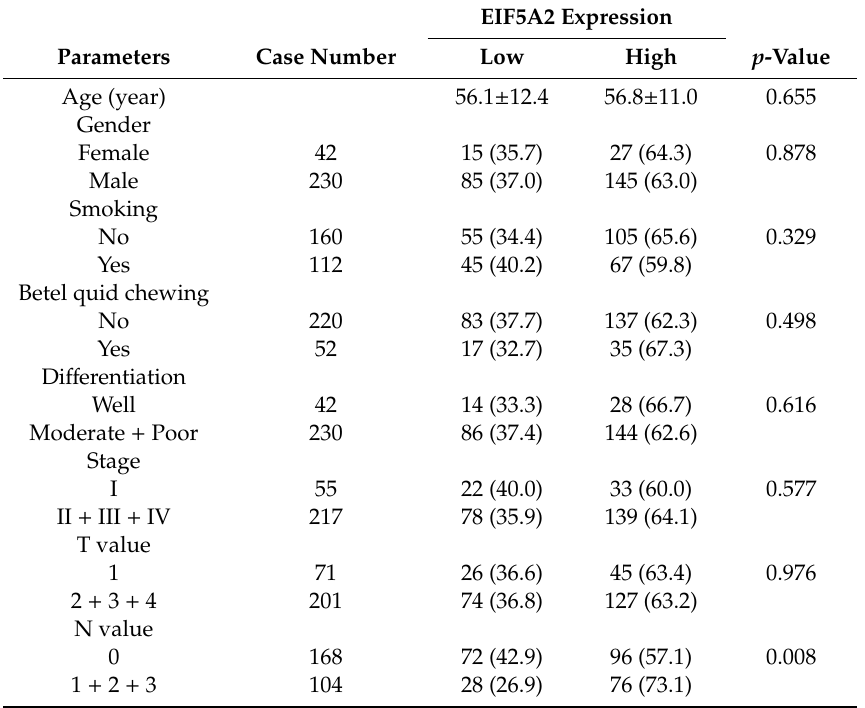
Table 1. Relationships between EIF5A2 expression and clinical parameters in oral cancer patients.